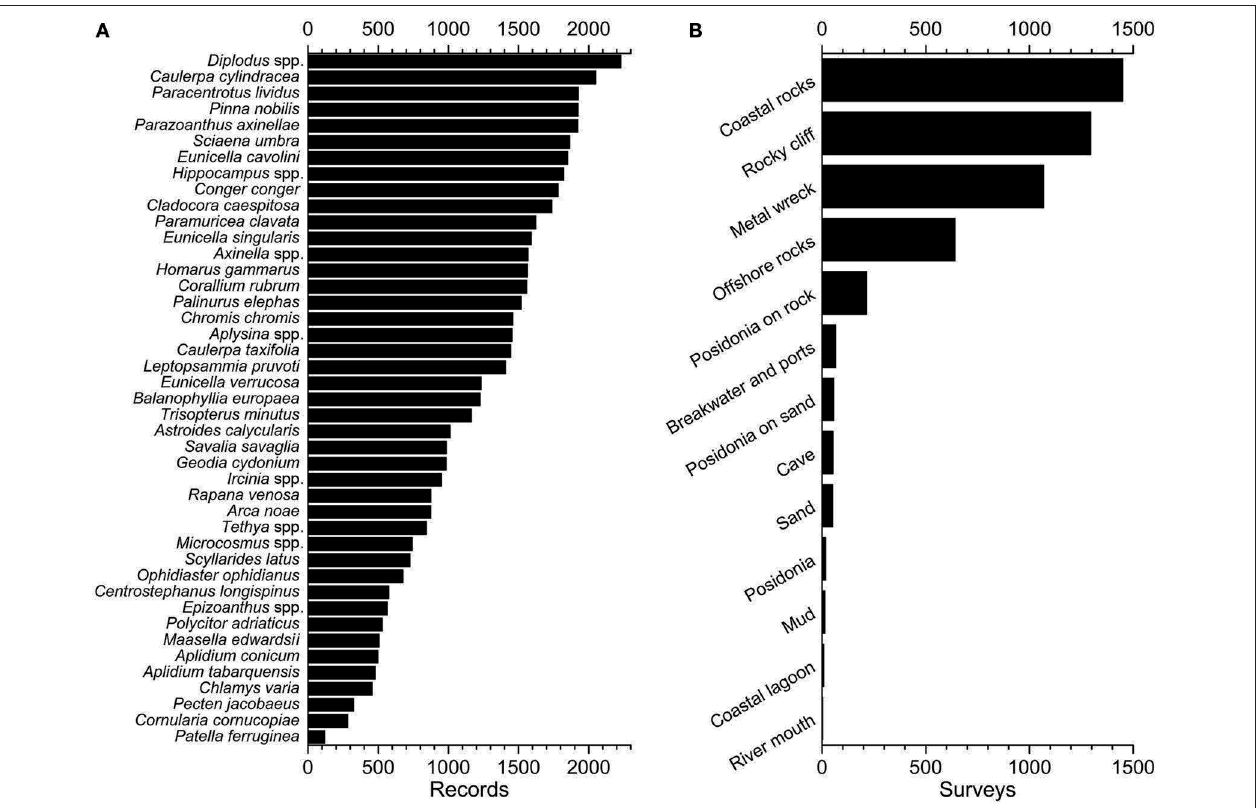
FIGURE 6 | Dataset contents (last access October 18th, 2020): (A) number of records (including absences) for each target species and (B) number of surveys carried out at each